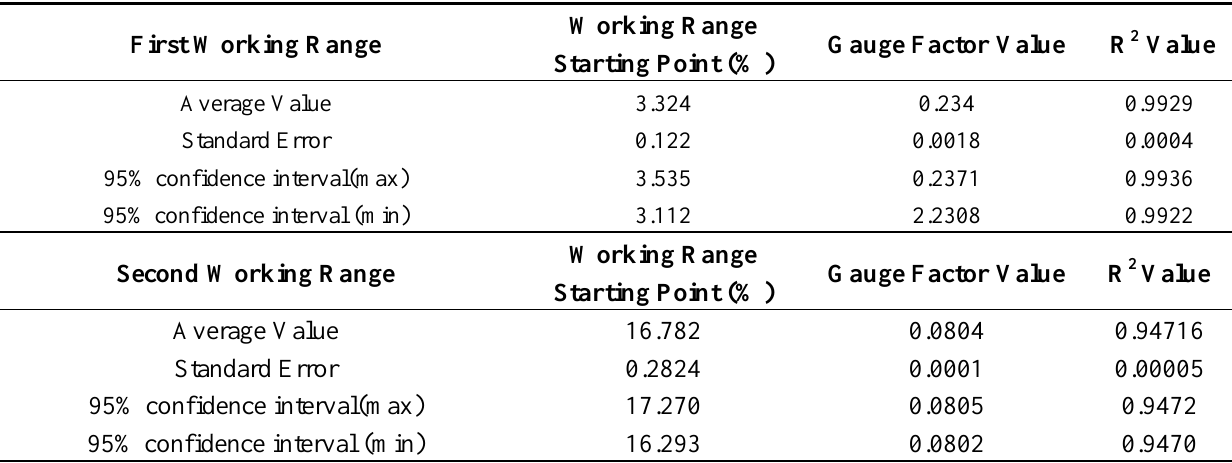
Table 5. Statistical results of Type 3